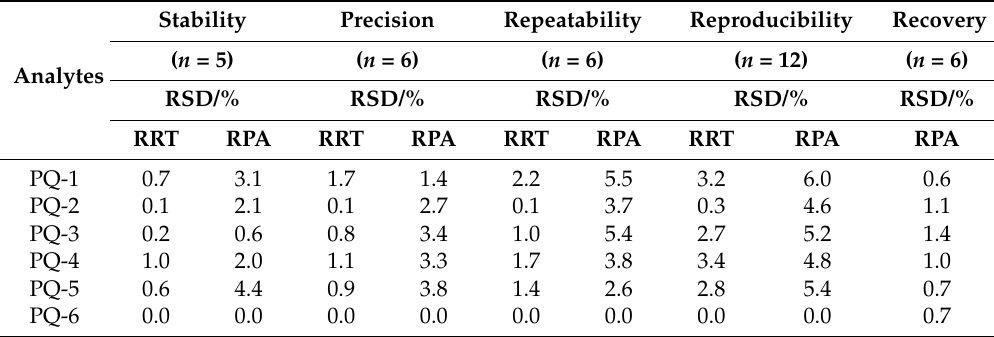
Table 1. Results of stability, precision, repeatability, reproducibility, and recovery tests for the QAMS method 1 .